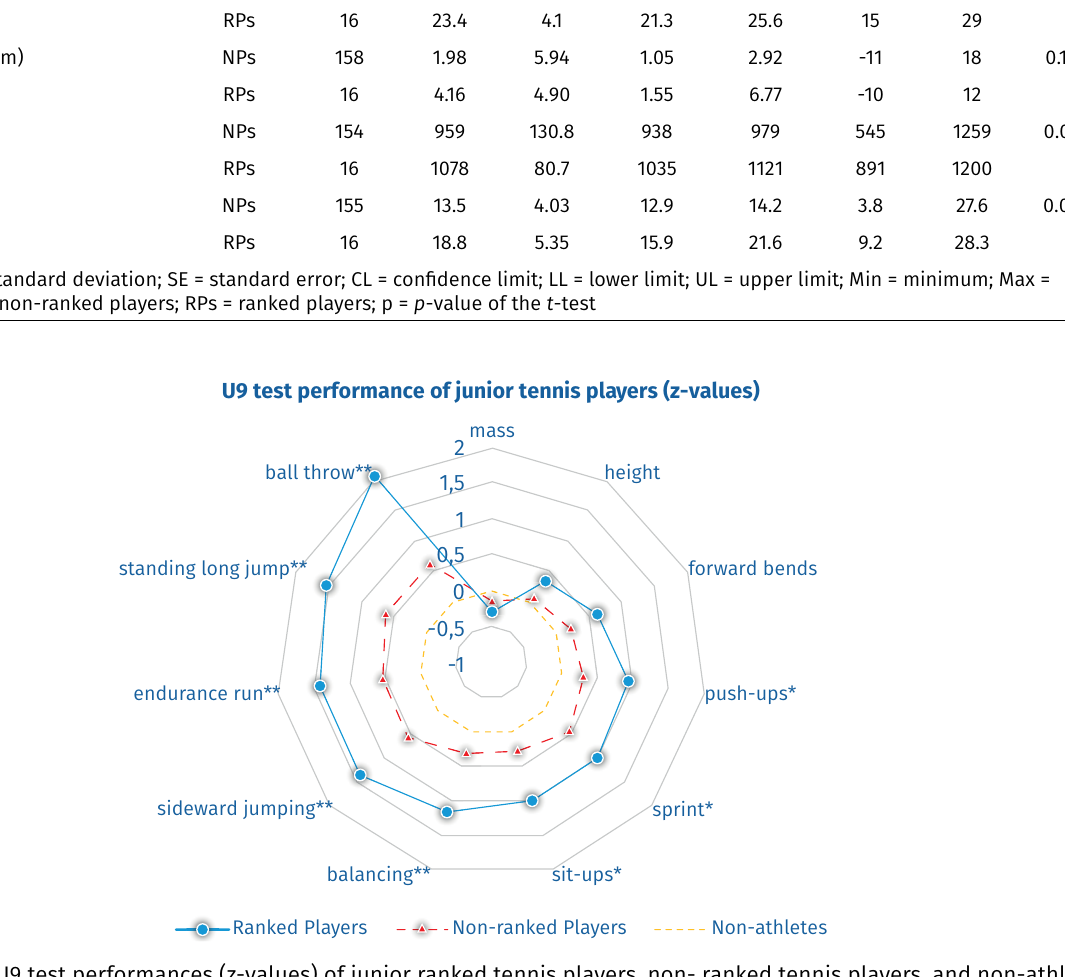
Figure 2. Initial U9 test performances (z-values) of junior ranked tennis players, non- ranked tennis players, and non-athletes (* p ≤ 0.05; ** p ≤